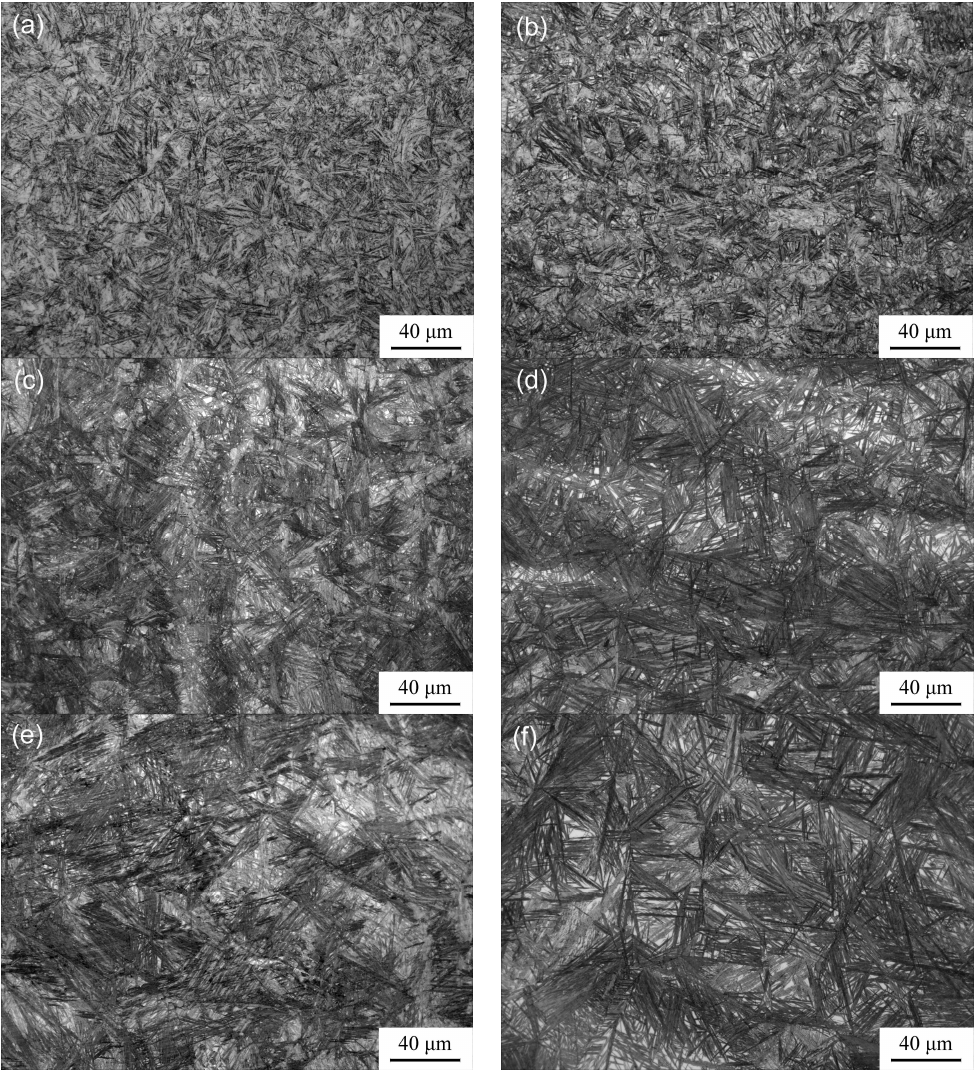
Figure 2. OM images of microstructures in samples isothermally transformed at ( a , c , e ) 220 °C and ( b , d , f ) 260 °C after austenitised at ( a , b ) 900 °C; ( c , d ) 1000 °C; and ( e , f ) 1150 °C.